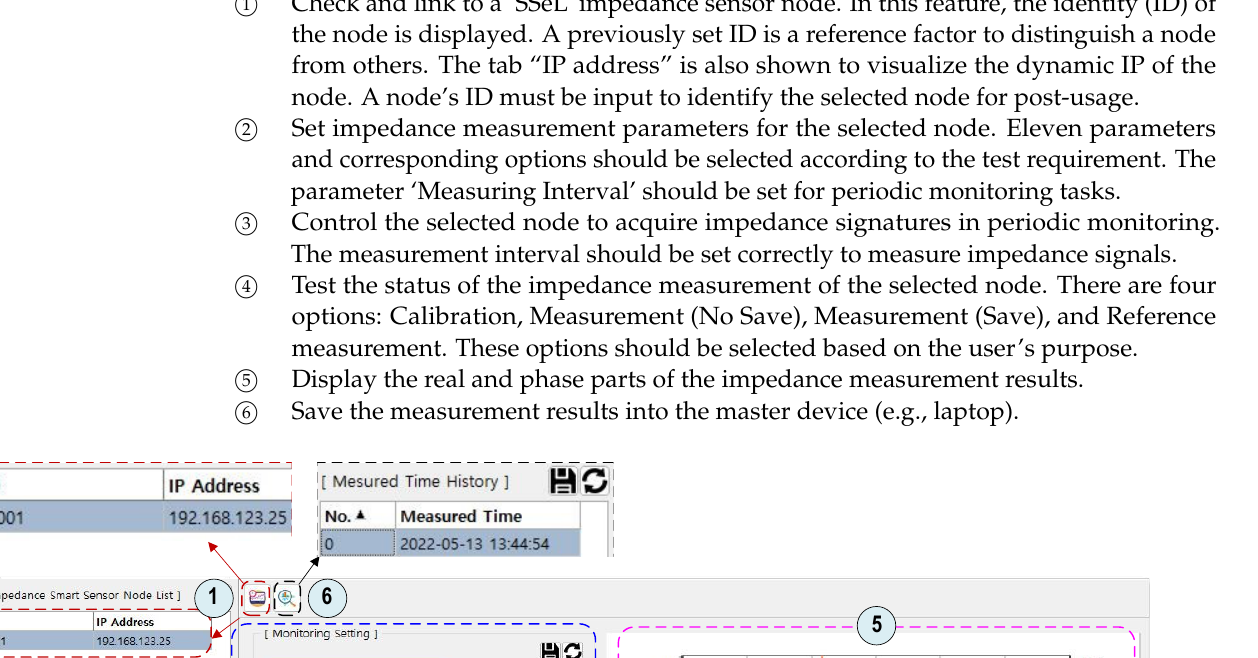
Figure 8. Control scheme of impedance monitoring system ‘ SSeL-Pi ’ .